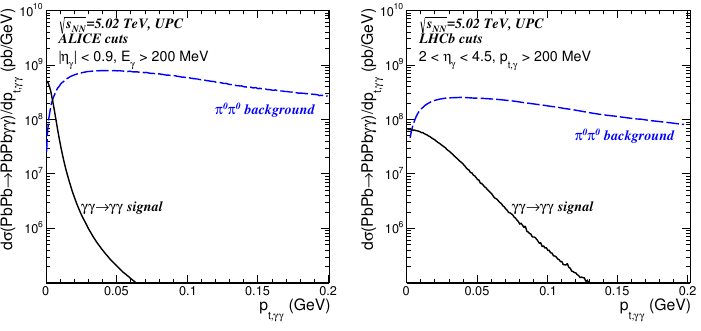
Figure 3. The di ff erential cross section as a function of p t ,γγ = ( | (cid:126) p t 1 + (cid:126) p t 2 | ) (transverse momentum of the diphoton pair) for the PbPb → PbPb γγ reaction at